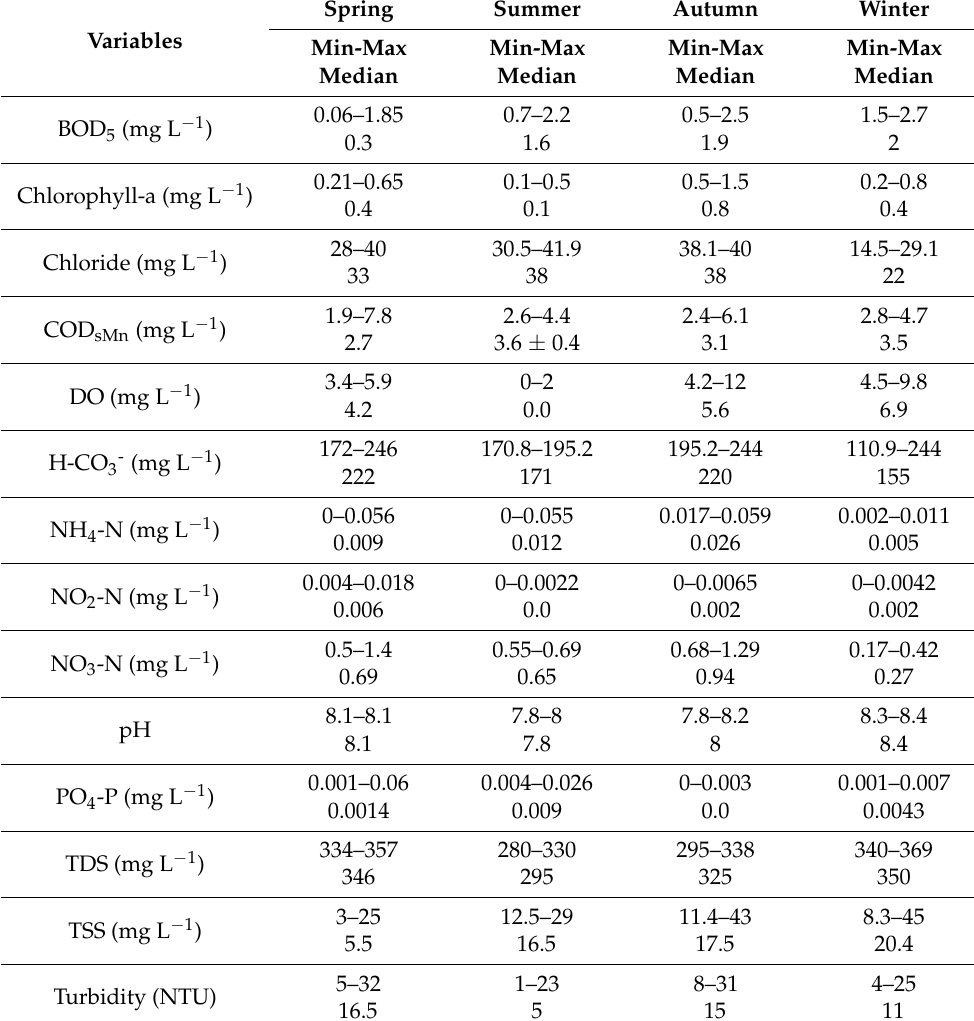
Table 1. The maximum, minimum, and median values of the physical and chemical variables measured during the investigated periods.